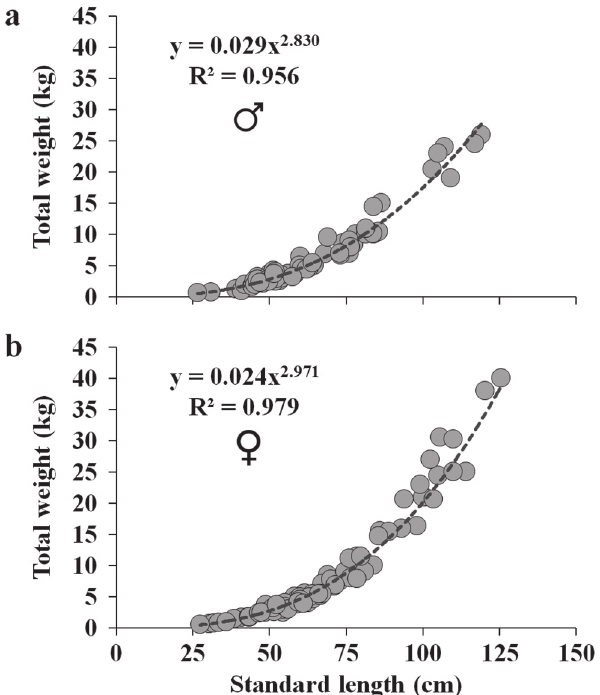
Fig. 2. Length-weight relationship of the red-tailed catfish Phractocephalus hemioliopterus specimens collected from the Xingu River in Pará, Brazil. a. males; and b. females.